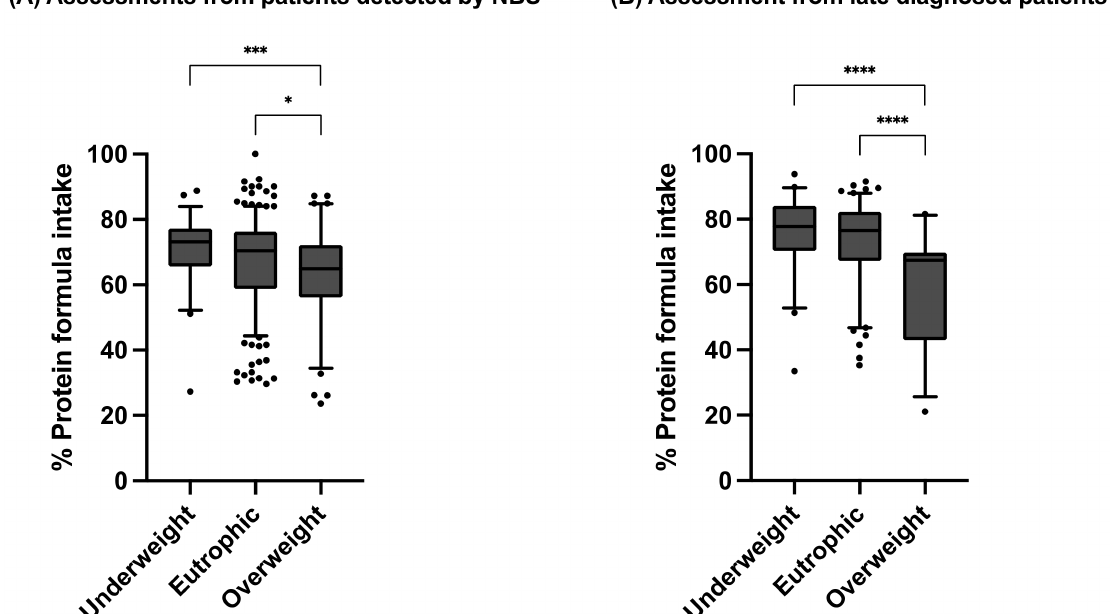
Figure 5. Percentage of protein intake from Phe-free nutritional formula in assessments from dietary recalls of PKU patients. ( A ) Assessments from patients detected by NBS. ( B ) Assessments from late-diagnosed patients. P:E ratio is presented as median with 5–95th percentile. Statistical differences between the studied age groups were calculated. A p -value < 0.05 was considered statistically significant (* p < 0.05, *** p < 0.001, **** p < 0.0001). Nutritional status was assessed according to BMI Z-Score. Age groups: infants (<2 years), preschoolers (2 years to <6 years), schoolchildren (6 to <11 years) and teenagers (11 to 18 years).